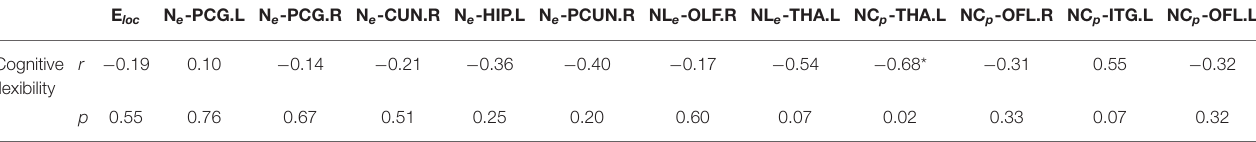
TABLE 3 | The results of Pearson correlation between topological parameters changes and cognitive flexibility